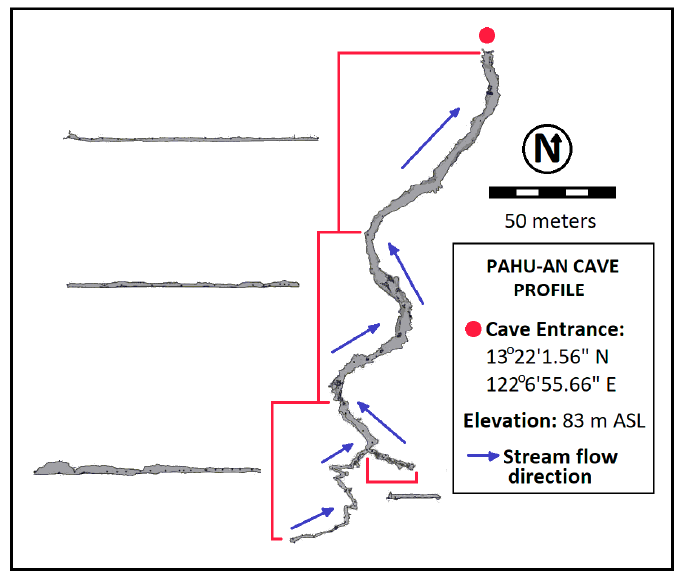
Figure 2. Pahu ‐ an Cave profile (modified from the Marinduque Cave Assessment Team map, unpublished )